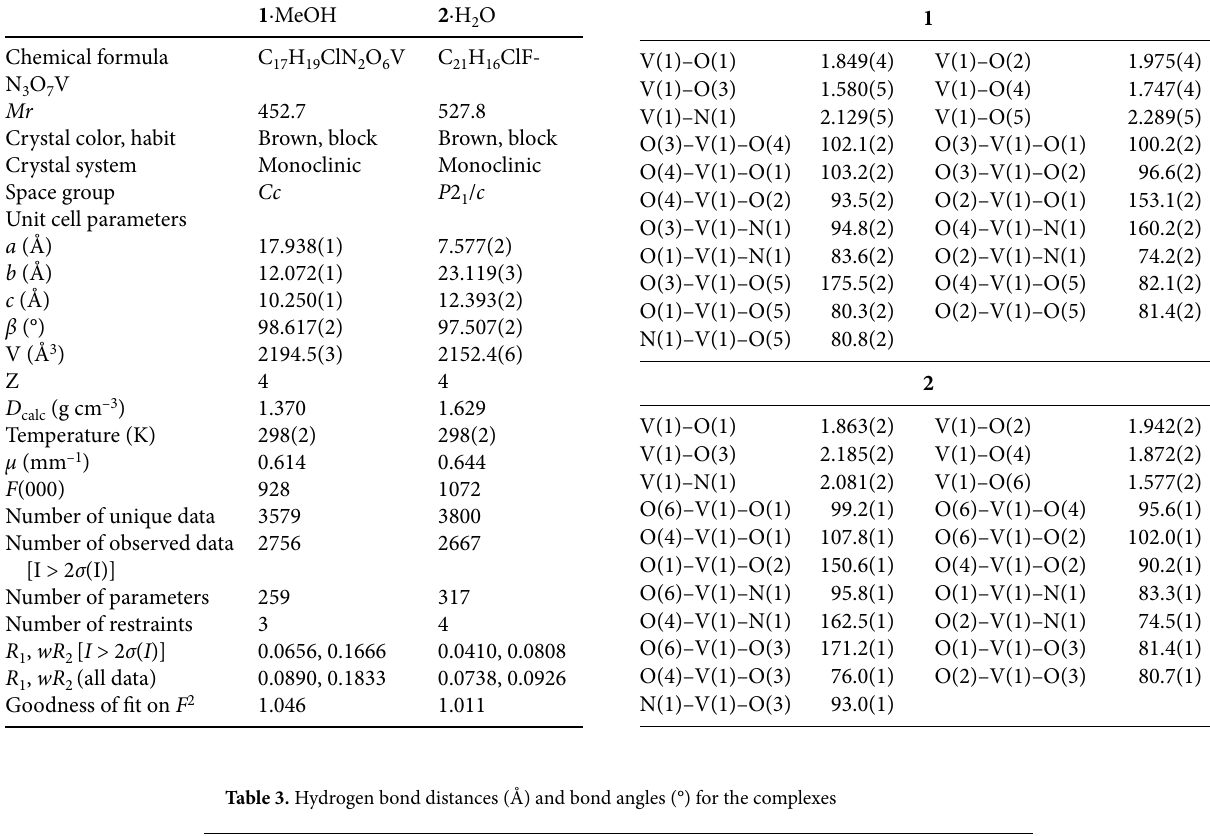
Table 2. Selected bond distances (Å) and angles (°) for the complex- es